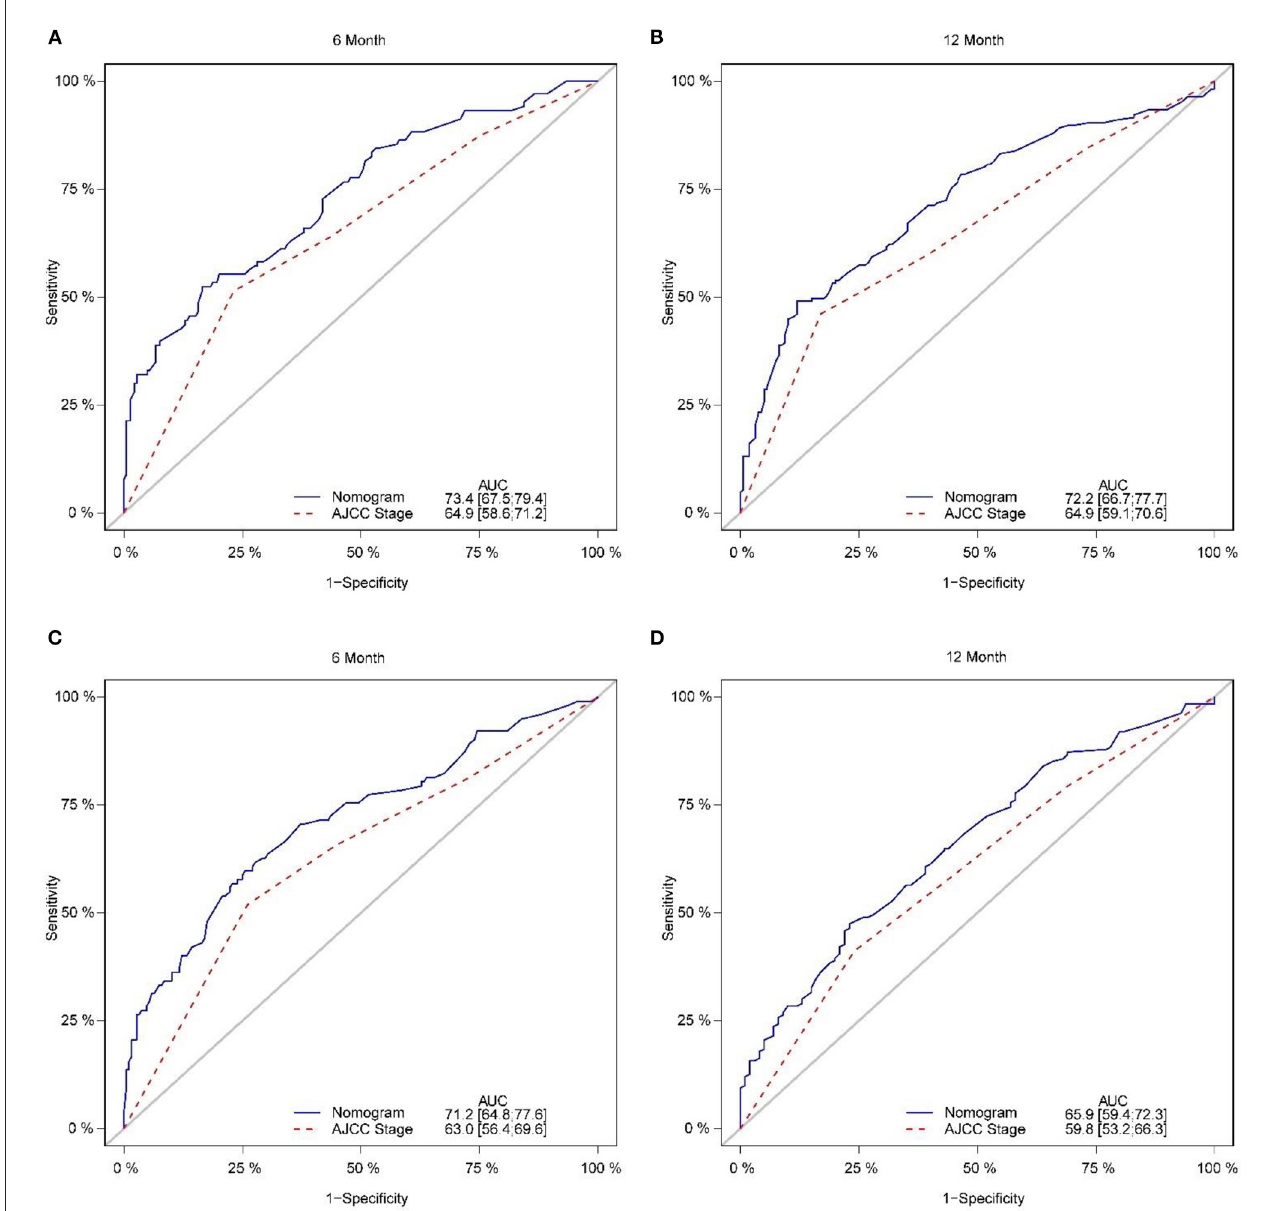
FIGURE5 Comparison of the ROC curves of the nomogram and the TNM stage system for 6-, and 12-month CSS prediction in the training set (A, B) . And the ROC curves of the nomogram for 6-, and 12-month CSS prediction in the verification set (C, D) . CSS, cancer-specific survival.